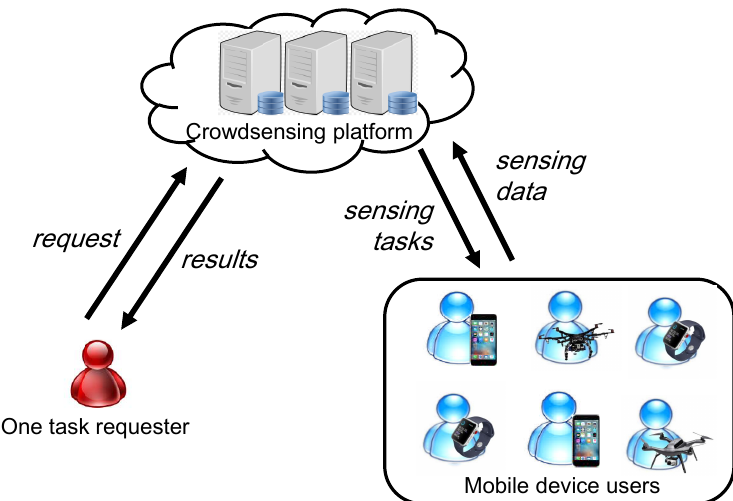
Figure 1. The structure of the crowdsensing